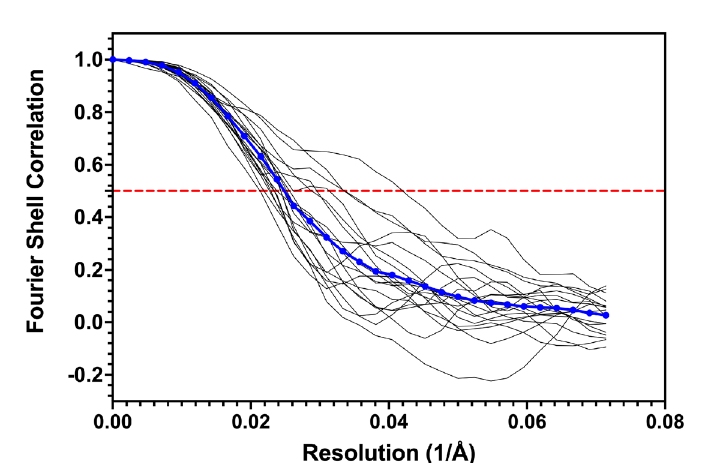
Figure 7. Electron density reconstruction of WT GRB2 dimer in solution calculated from scattering data using DENSS. ( A ) Orthogonal views with 90° rotation of the proposed full-length SH2/SH2-mediated domain- swapped dimer model superposed onto the electron density reconstruction are shown. One protomer is depicted as in Fig. 1, with the N-terminal SH3 domain in green, central SH2 domain in blue, and C-terminal SH3 domain in orange, linkers in grey, and poly-histidine-tag in red. The other protomer is shown entirely in grey for contrast. ( B ) The averaged FSC curve as a function of reciprocal electron density resolution is shown. The red, dotted line indicates the resolution limit, where the FSC falls below